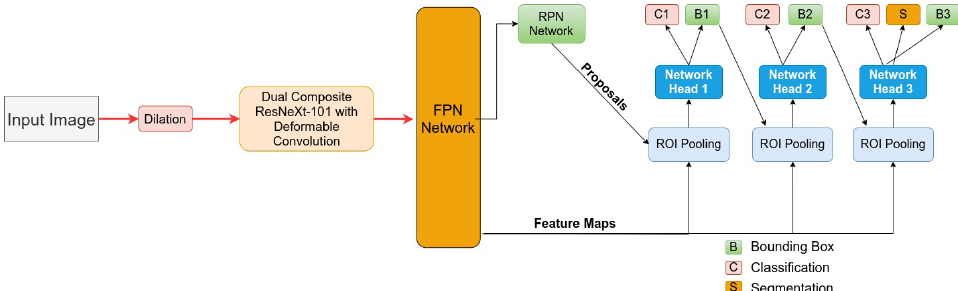
Figure 3. The presented framework is based on Cascade Mask R-CNN equipped with a deformable composite backbone applied on dilated document images. Modules B, C, and D represent bounding box, classification, and segmentation,